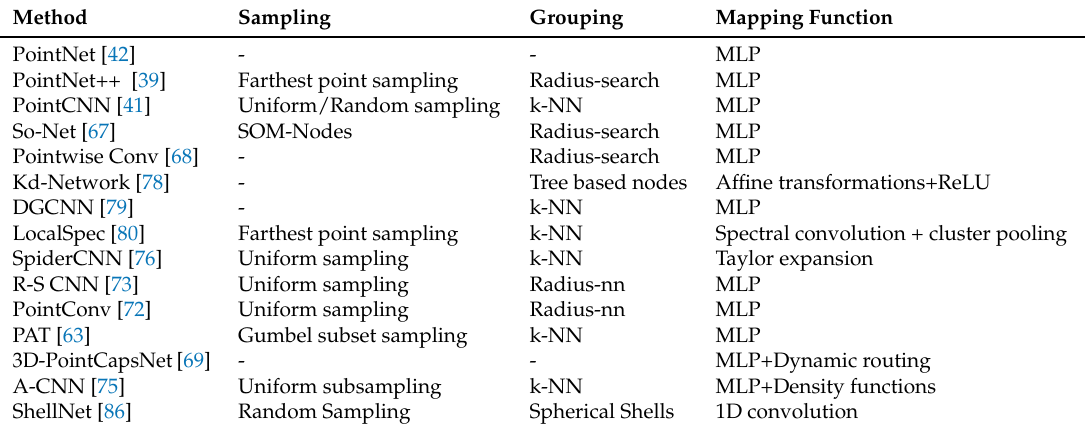
Table 1. Summary of methods showing the sampling, grouping, and mapping functions used. CNN: convolutional neural network; DGCNN: dynamic graph CNN; SOM: self-organizing map; k-NN: k-nearest neighbor; MLP: multi-layer